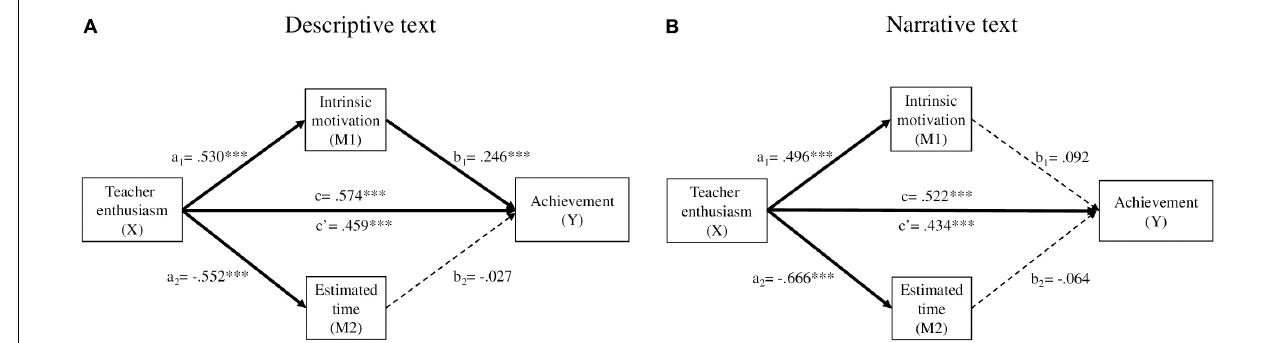
FIGURE 4 | Analysis of mediation through intrinsic motivation and estimated time as a function of teacher enthusiasm over achievement: descriptive text model (A) and narrative text model (B) . a 1 , a 2 , b 1 , b 2 , c’ = path coefficient (unstandardized coefficient). * p < 0.05, ** p < 0.01, *** p < 0.001. (A) Descriptive text: Direct effects B = 0.459, SE = 0.111, t = 4.151, p ≤ 0.000, 95% CI [0.242, 0.676]. Indirect effects B = 0.115, SE = 0.043, 95% CI [0.035, 0.204]. Total effects B = 0.574, SE = 0.106, t = 5.418, p ≤ 0.000, 95% CI [0.366, 0.782]. (B) Narrative text: Direct effects B = 0.434, SE = 0.104, t = 4.164, p ≤ 0.000, 95% CI [0.229, 0.638]. Indirect effects B = 0.088, SE = 0.036, 95% CI [0.022, 0.163]. Total effects B = 0.522, SE = 0.098, t = 5.303, p ≤ 0.000, 95% CI [0.328,